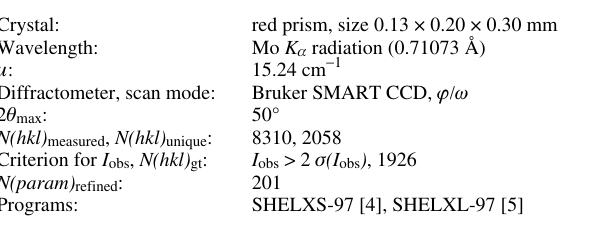
Table 1. Data collection and